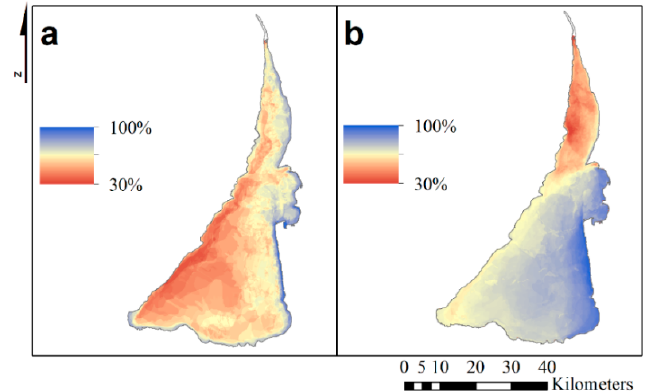
Figure 13. The spatial variations of the ice cover extent during ( a ) ice formation and ( b ) ice melting periods. The colors represent the percentage of ice observations during these periods, i.e., blue color in ( a ) shows the areas where the ice starts to form first, while the red color in ( b ) shows the areas where the ice melts first.